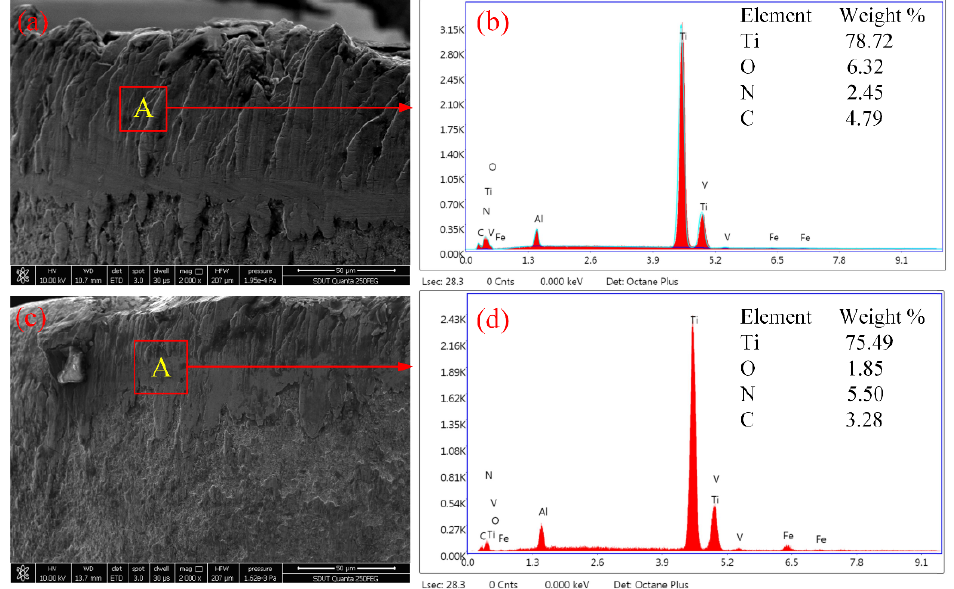
Figure 5. EDS spectra of Point A ( a , b ) under dry machining and ( c , d ) ultrasonic atomization assisted machining.